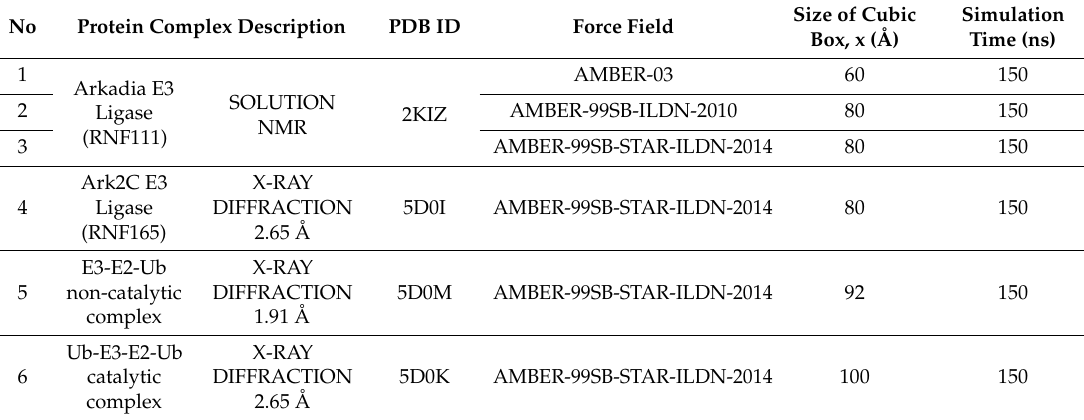
Table 3. A list of all systems simulated in this work with their relevant